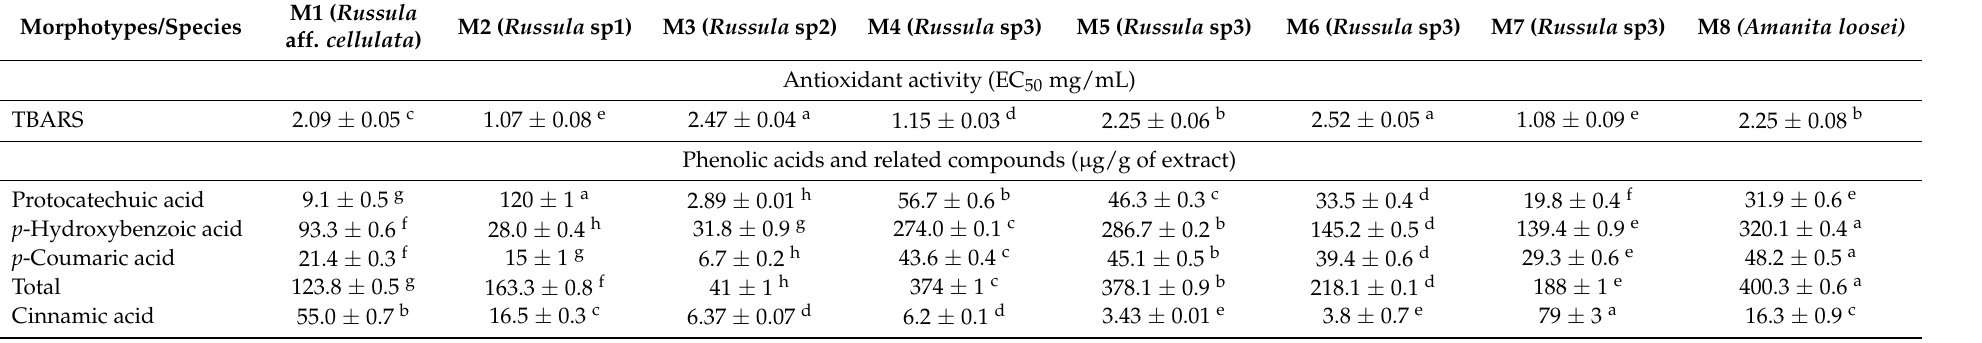
Table 3. Antioxidant activity, phenolic acids, and related compounds of the studied mushroom hydroethanolic extracts (mean ± SD, n = 3).